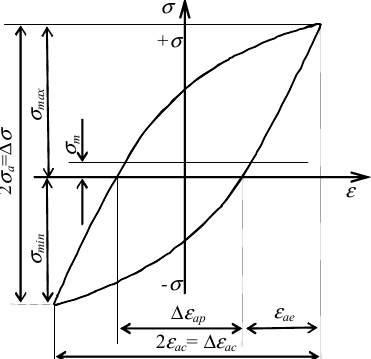
Figure 4. Hysteresis loop and its basic parameters.